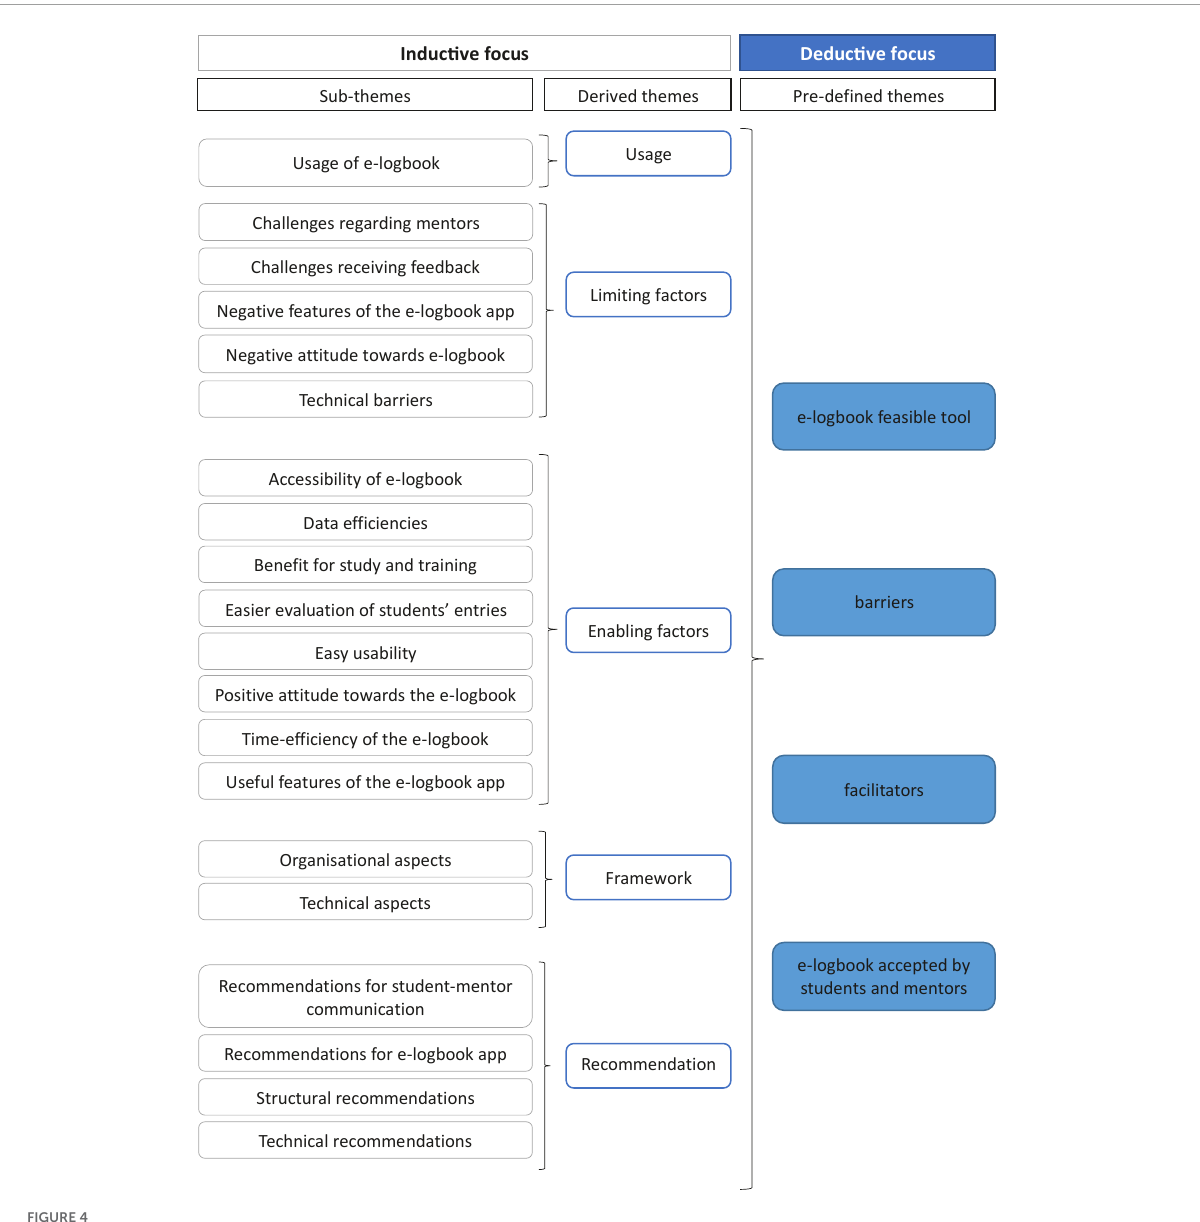
FIGURE4 Overview of methodological approach, showing the inductive and deductive process.